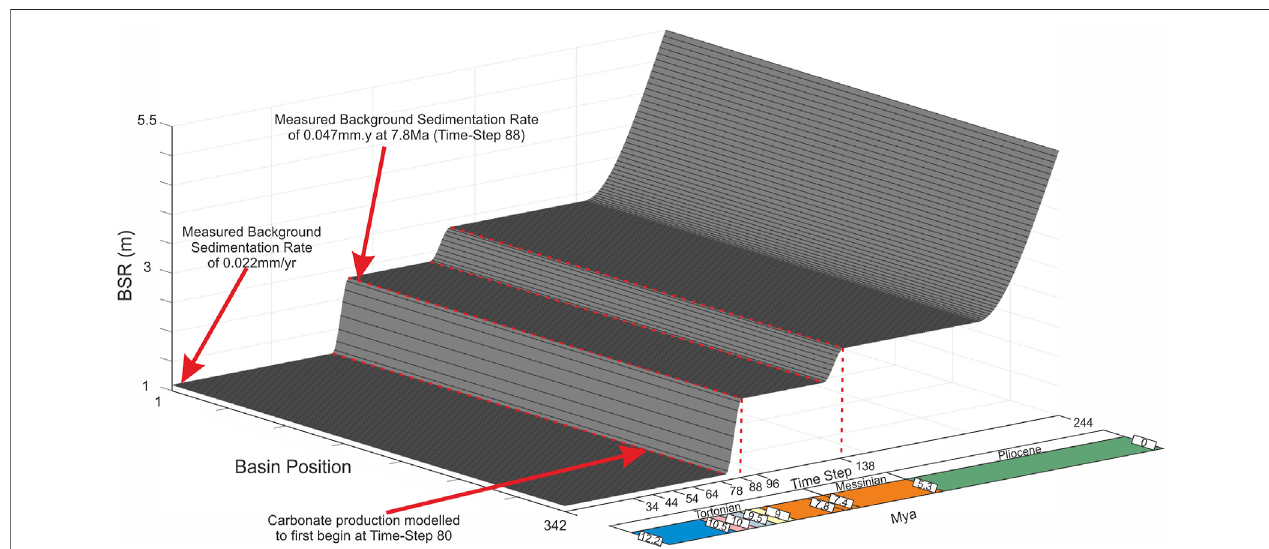
FIGURE 13 | 3D representation of Background Sedimentation Rate as it evolves through time. Derived from well data from Well-A. X axis represents position in Time,showing both Time-Step and wherein thechronostratigraphiccolumn each event is.Yaxis representspositionalongthecross-section. Zaxis representstherate of Background Sedimentation in